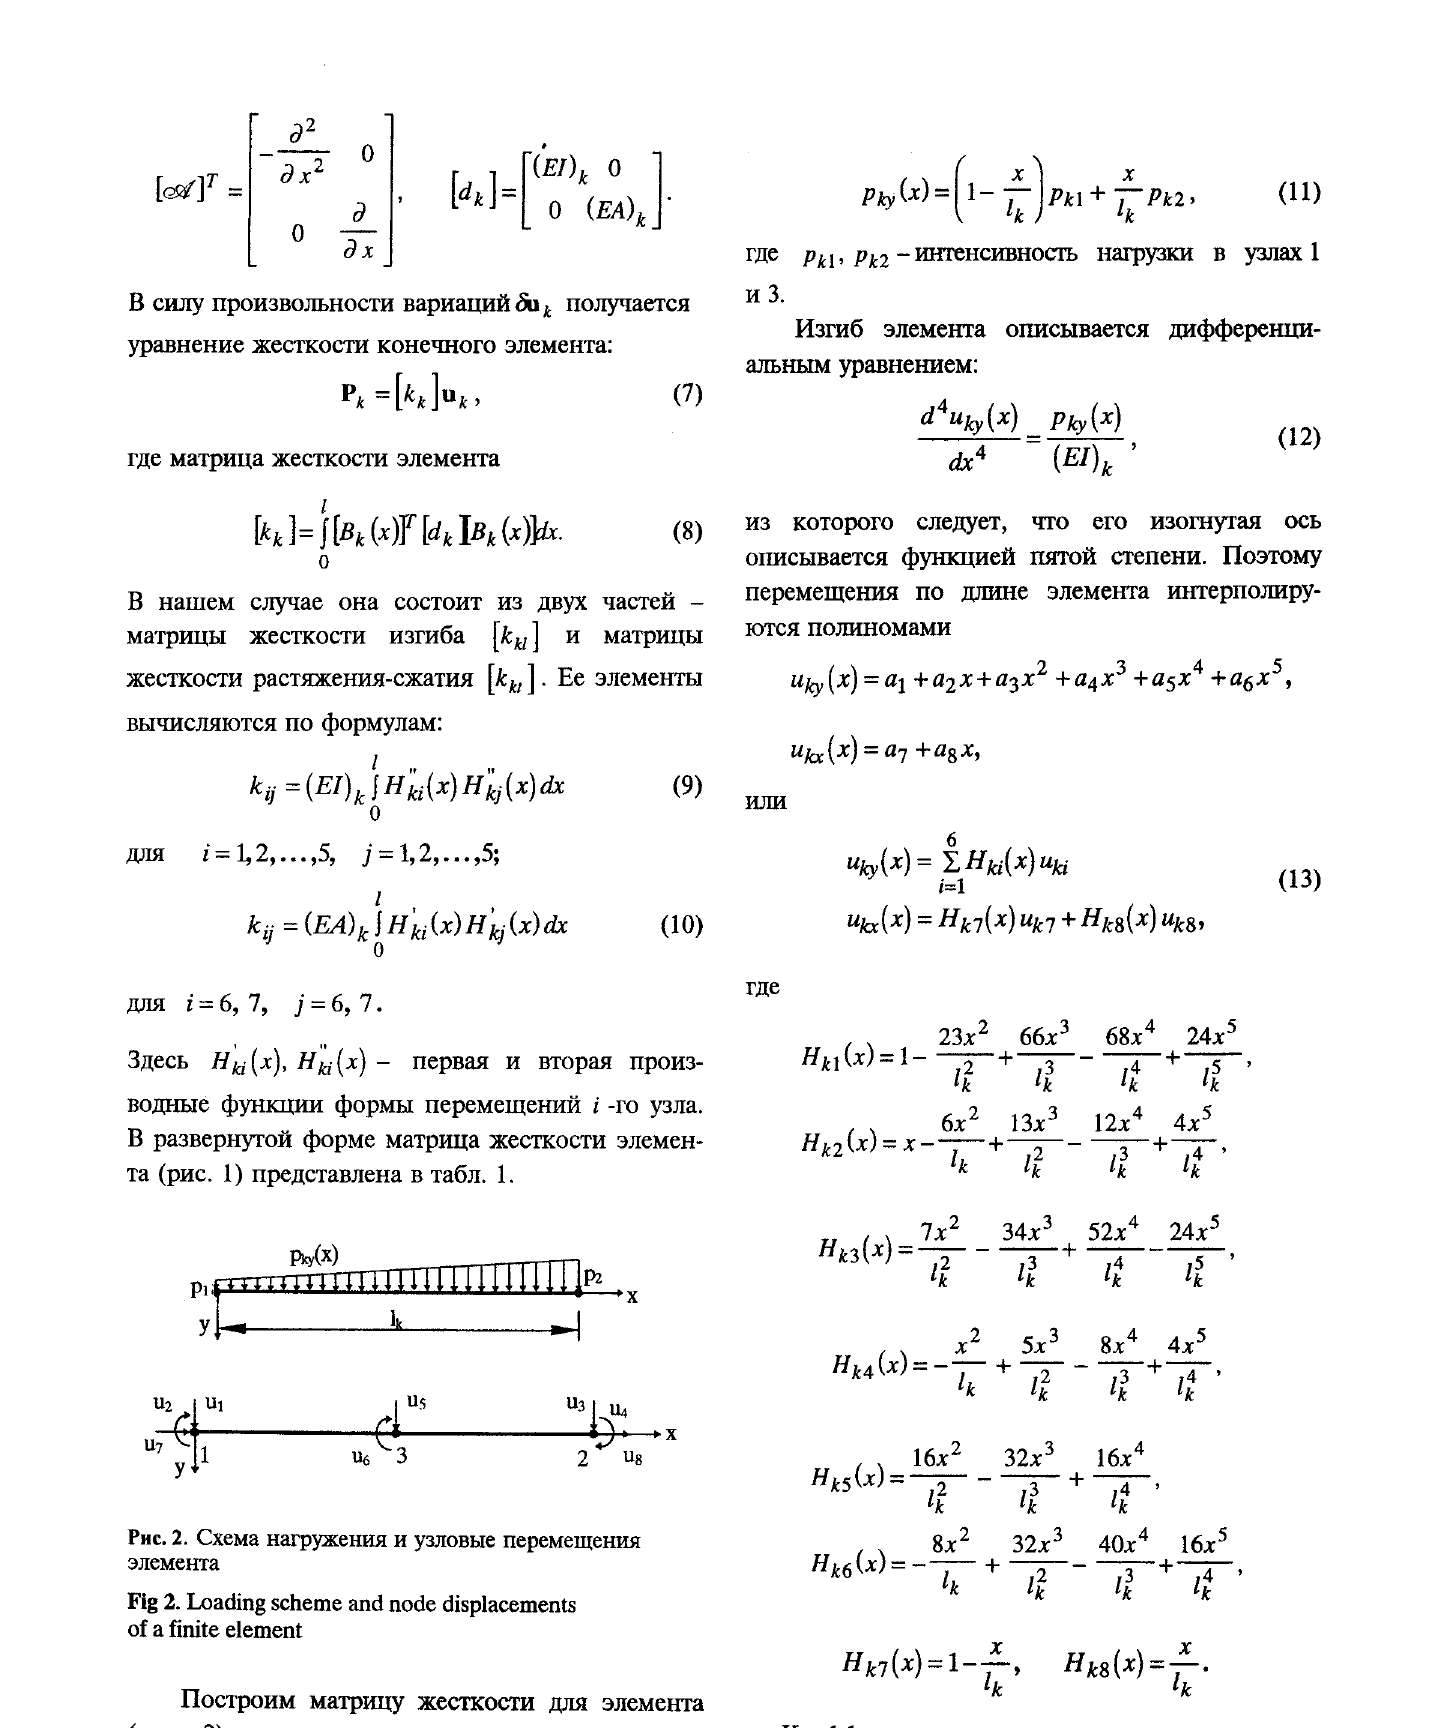
Fig 2. Loading scheme and node displacements of a finite